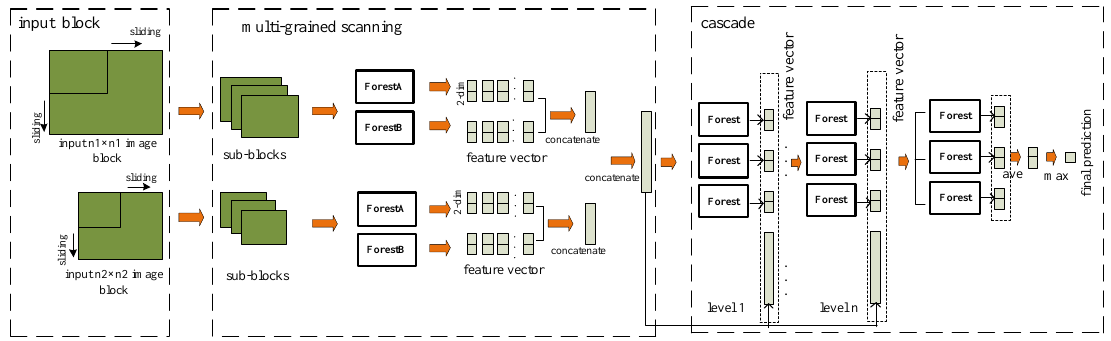
Figure 5. Two different size image blocks as the input of the model. These two block features can be fused through the multi-grained part of the model, and the fusion feature is classified by the cascaded part of the model. The output of the multi-grained scanning will cascade with every level of the cascaded part of the model until the best result generates, average every class value, and then select the maximum class value, which is the final prediction class.